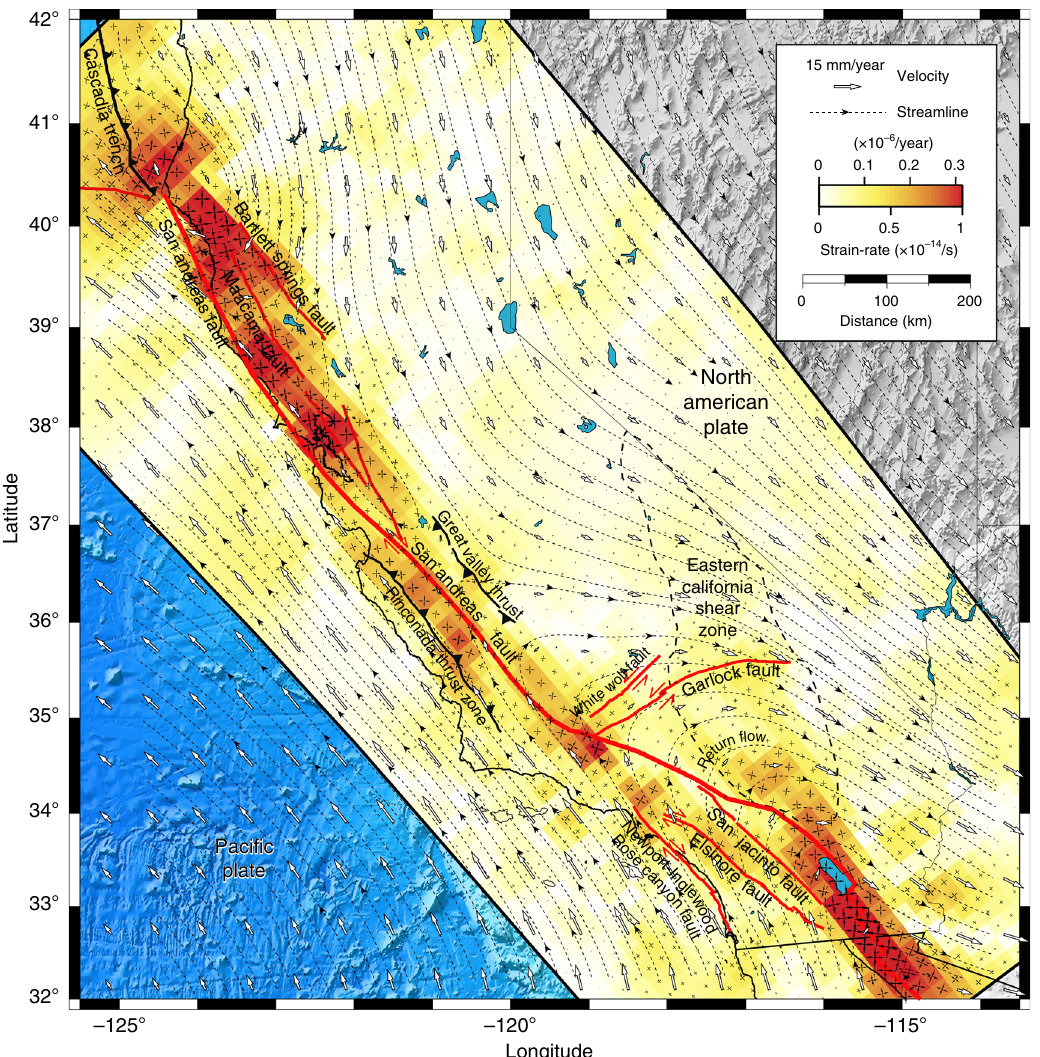
Fig. 3 Contribution of viscoelastic fl ow on plate boundary deformation. The background color indicates the spatial distribution of strain accumulation (the norm of the strain-rate tensor) along the plate boundary. The pairs of black arrows indicate the principal axes of the strain-rate tensor. The white arrows indicate the surface velocity predicted by the model. The dashed black lines with arrows are the fl ow streamlines. The thick red lines indicate the surface trace of major strike-slip faults. The thick dashed contour indicates the approximative extent of the Eastern California Shear